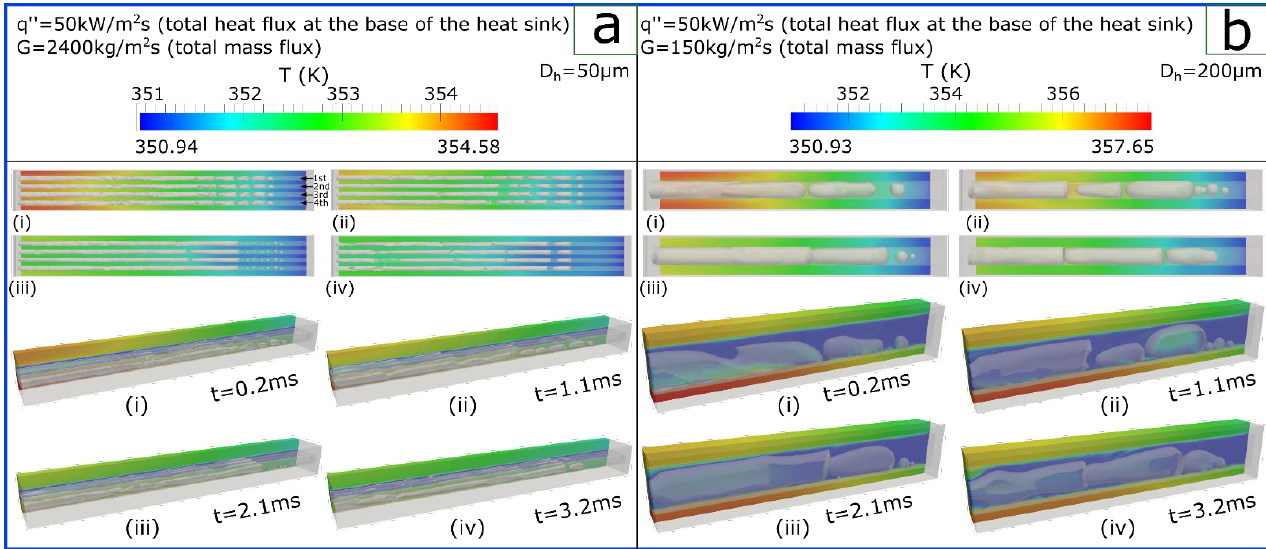
Figure 7. Top view and 3D side view comparison between the four parallel channels ( a ) and single case channel ( b ) for constant 𝑞 = 1.80 × 10 −2 W and 𝑉̇ = 9.1611 × 10 −9 . Four common time instants are shown.